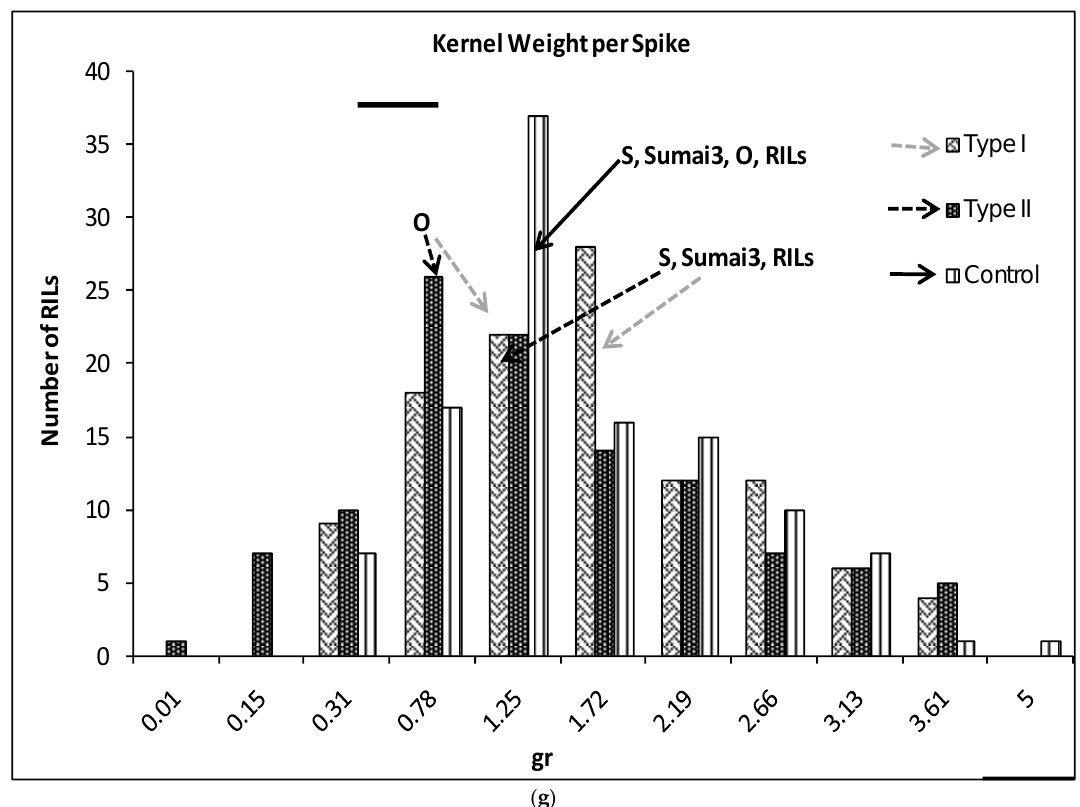
Figure 1. ( a – g ) Severity ( a ), Fusarium Index ( b ), thousand kernel weight (TKW) ( c ), Fusarium damaged kernel (FDK) ( d ), number of spikes ( e ), kernel weight per plant ( f ), and kernel weight per spike ( g ), recorded in ITMI/MP (Opata (O) x Synthetic (S)) assessed by Type I and II resistance and in their controls. Horizontal bar represents the standard error. Arrows indicate the mean values of parental lines, RILs and tolerant cultivar Sumai 3.